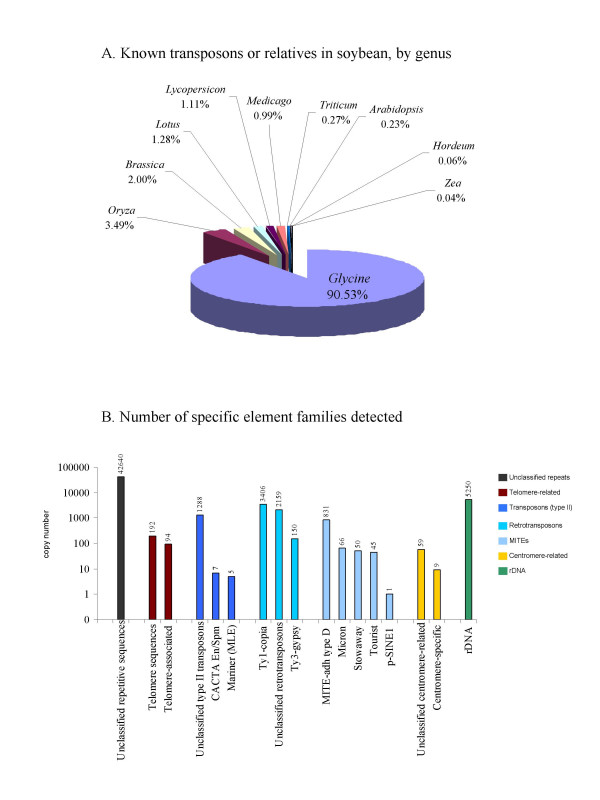
Comparison of sequence survey data with soybean and other plant repeat databases. A) Distribution of hits to plant repeat databases, by genus. Raw reads were matched using BLAST (blastn) to the TIGR plant repeat databases and the top significant (1E-6) hit recorded. Percentages represent the percentage of reads with hits to sequences from a particular organism with respect to all reads with hits to the TIGR repeats. B) Distribution of hits to plant repeat databases, by class of repetitive element Raw reads from the genomic sequence survey were matched to the combined plant repeat databases as for (A), and the class of repetitive element for the top hit was used to show the relative abundance of different classes of repetitive elements. This gives an estimate of the relative frequency of these families in the soybean genome. Retrotransposons and rDNA are the most common classes of repeat. See Additional File 1 for common repeat sequences not included in the TIGR database.